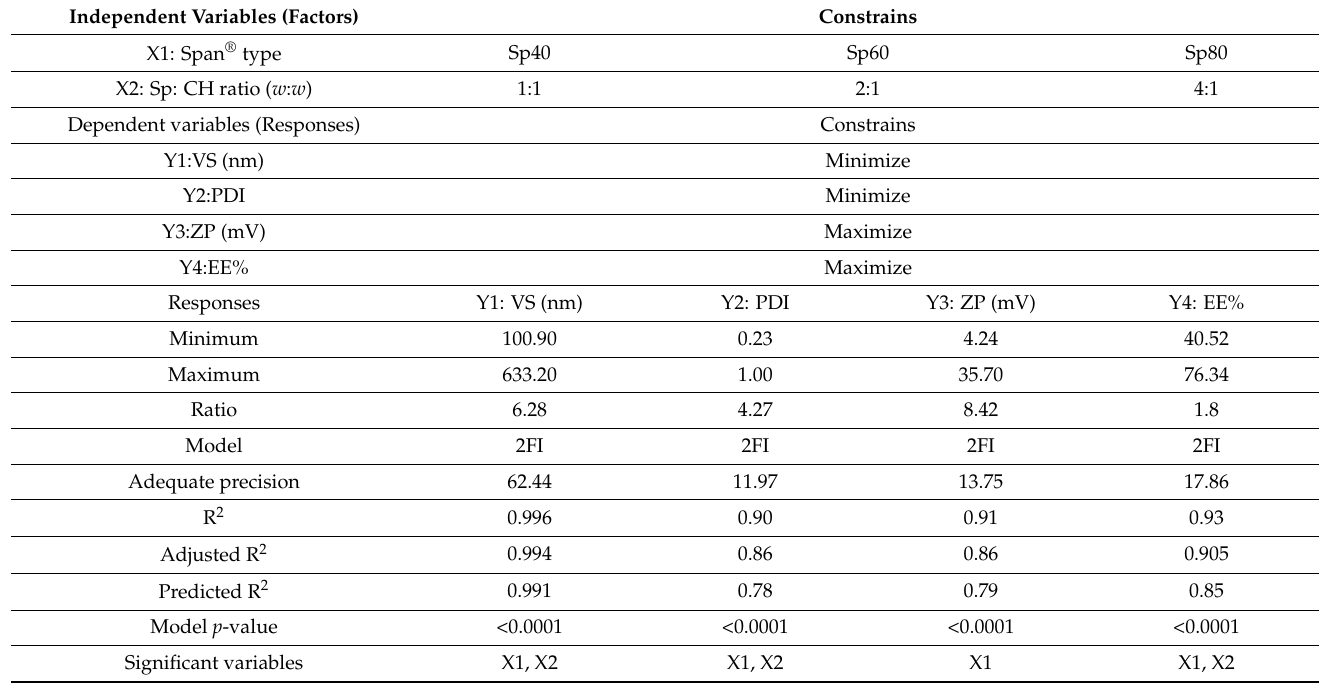
Table 1. The model summary statistics of 3 2 full factorial design used for optimization of DRN loaded niosomes a